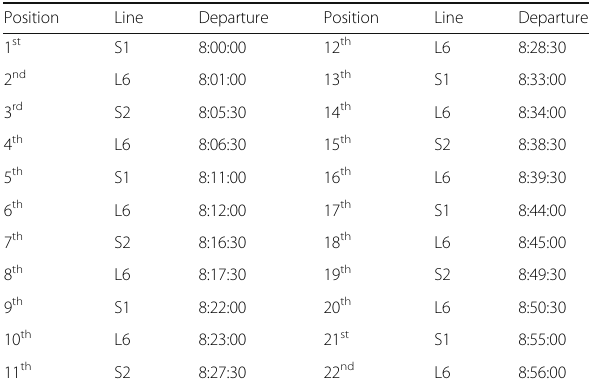
Table 2 Simulated timetable of trains departing from